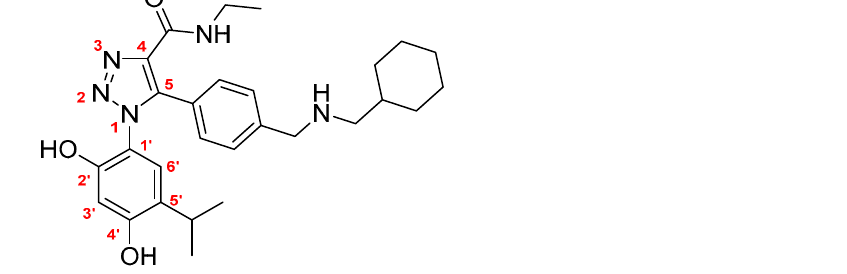
Figure 1. Chemical structure of JMC31. The atom numbering mentioned in the text is